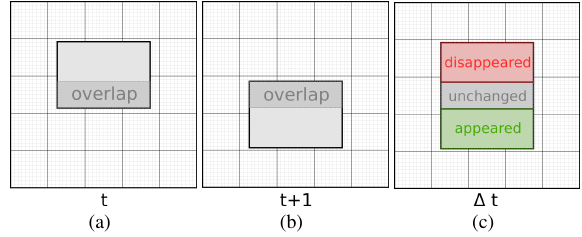
Figure 3. An object partially moved between (a) epoch t and (b) epoch t+1 is usually recognized as (c) an appeared and a disappeared cluster with an unchanged area in